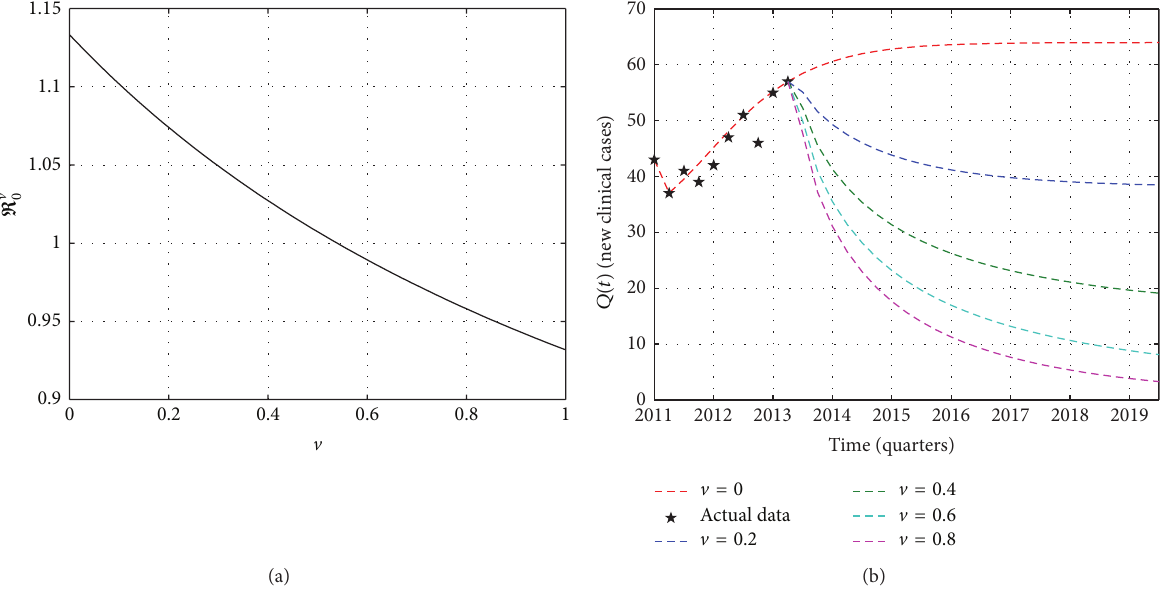
Figure 5: (a) R V 0 in terms of V . (b) New clinical cases with different values of V with system (22). Other parameter values are showed in Table 2.